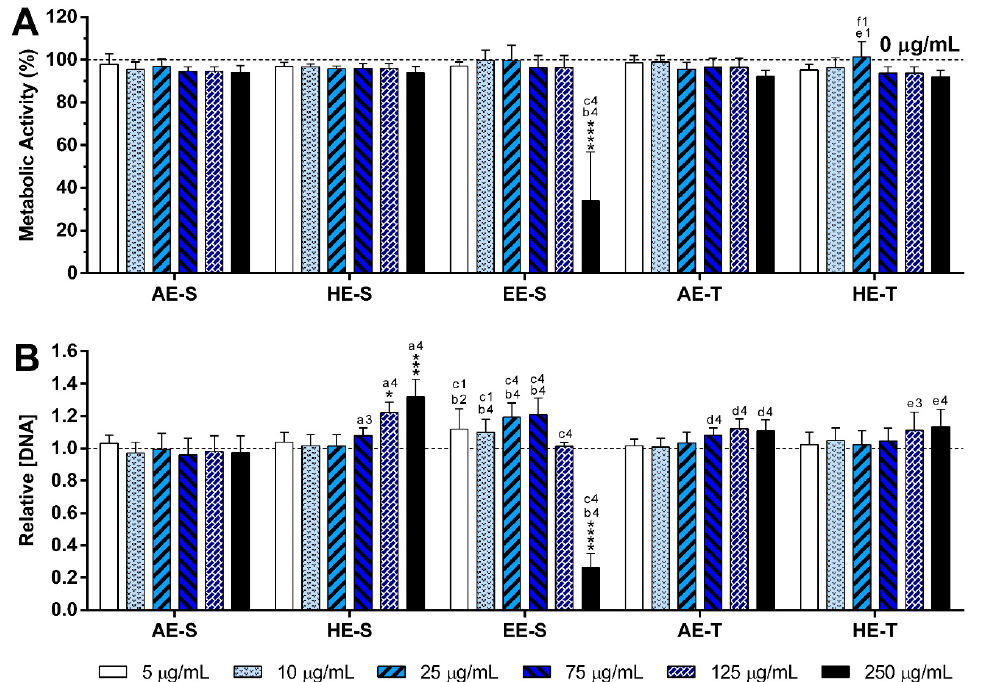
Figure 6. Metabolic activity ( A ) and relative DNA concentration ( B ) of nonstimulated macrophages cultured in the presence of different concentrations of the Salvia officinalis extracts for 24 h of culture at 37 °C. The dotted line represents the nontreated condition (0 µg/mL) for each assay. Statistically significant differences are * ( p < 0.0384), *** ( p < 0.00109) and **** ( p < 0.0001) in comparison to the negative control (0 µg/mL) for each different tested extract, and 1 ( p < 0.0251), 2 ( p < 0.095), 3 ( p < 0.0005), and 4 ( p < 0.0001) in comparison with a (AE-S vs. HE-S), b (AE-S vs. EE-S), c (HE-S vs. EE-S), d (AE-S vs. AE-T), e (HE-S vs. HE-T), and f (AE-T vs. HE-T). AE: aqueous extracts; HE: hydroethanolic extracts; EE: ethanolic extracts; S: soxhlet extraction; T: traditional extraction.